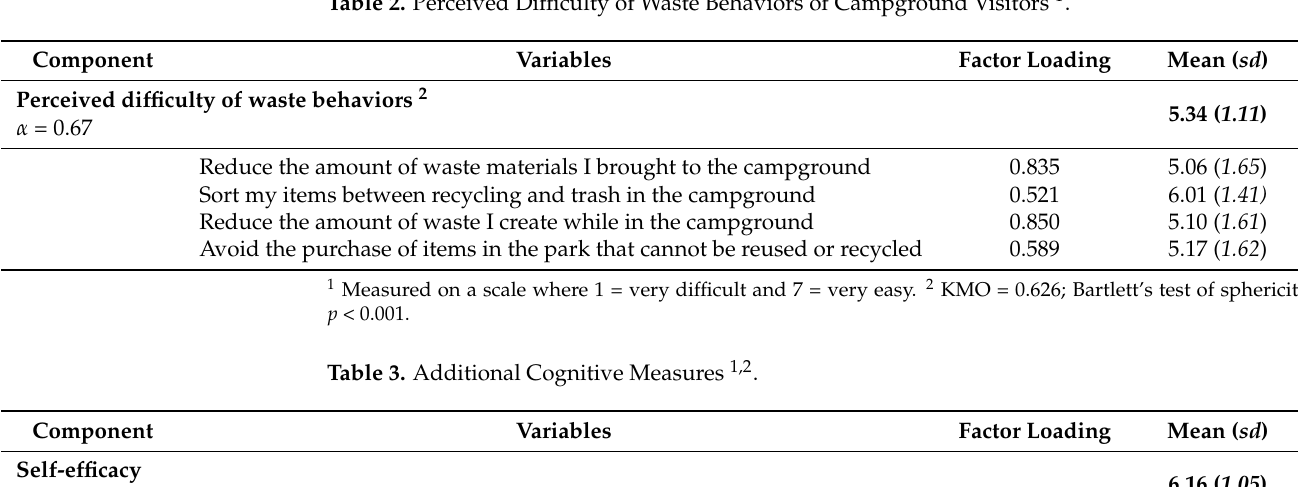
Table 2. Perceived Difficulty of Waste Behaviors of Campground Visitors 1 .